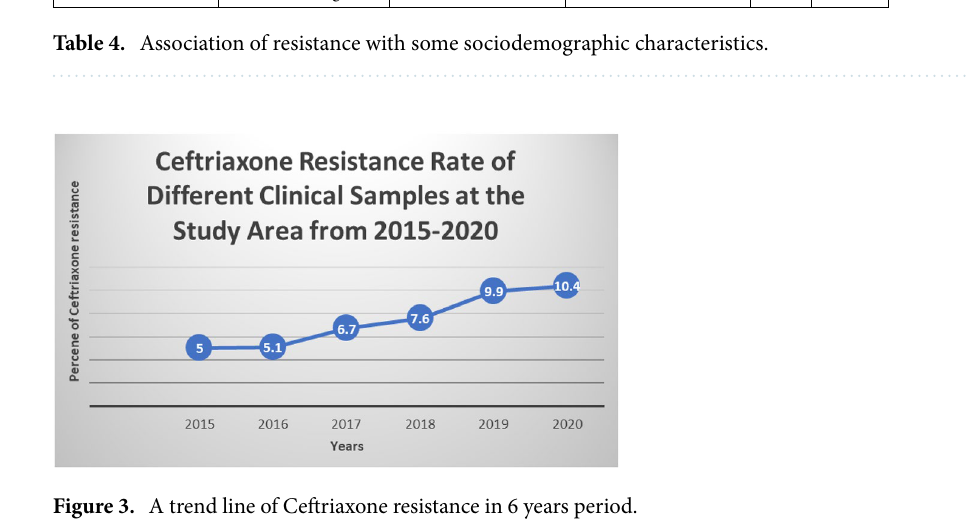
Figure 3. A trend line of Ceftriaxone resistance in 6 years